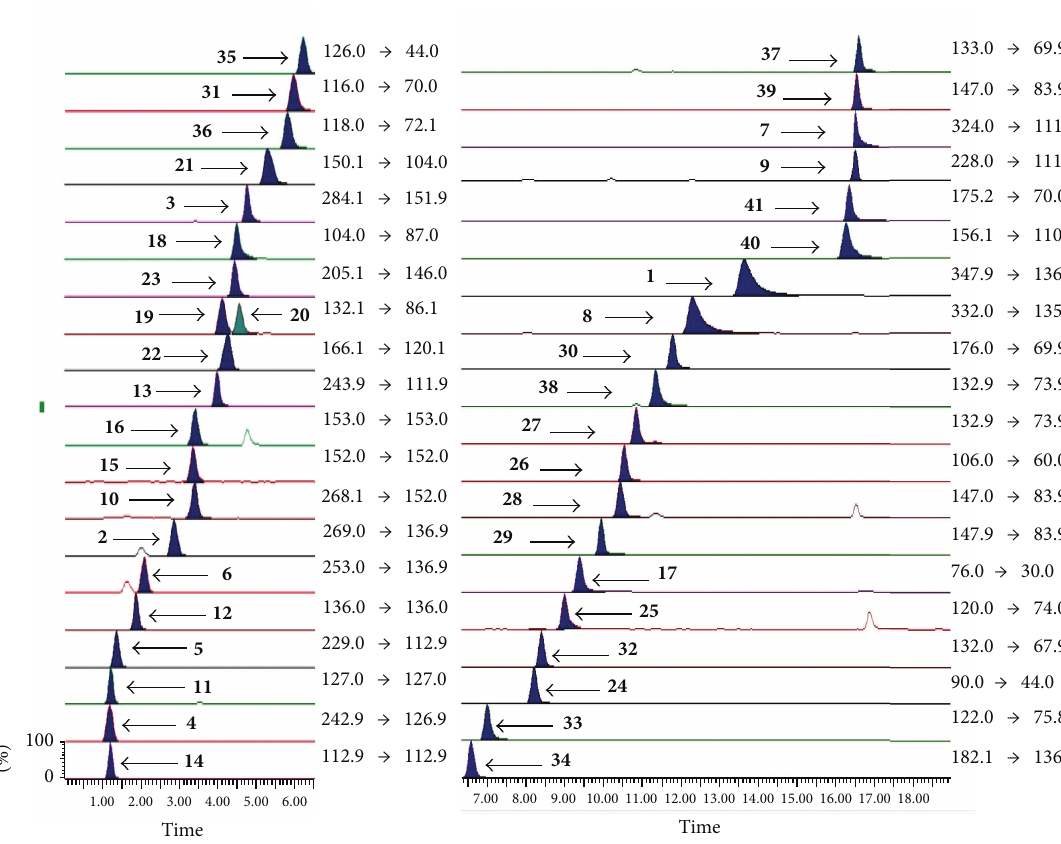
Figure 1: UPLC-TQ-MS/MS multiple-reaction monitoring (MRM) chromatograms of the samples. The compound numbers on the chromatograms were adenosine-5 󸀠 -monophosphate ( 1 ), inosine ( 2 ), guanosine ( 3 ), thymidine ( 4 ), 2 󸀠 -deoxyuridine ( 5 ), 2 󸀠 -deoxyinosine ( 6 ), cytidine-5 󸀠 -monophosphate ( 7 ), 2 󸀠 -deoxyadenosine-5 󸀠 -monophosphate ( 8 ), 2 󸀠 -deoxycytidine ( 9 ), 2 󸀠 -deoxyguanosine ( 10 ), thymine ( 11 ), adenine ( 12 ), cytidine ( 13 ), uracil ( 14 ), guanine ( 15 ), xanthine ( 16 ), glycine ( 17 ), GABA ( 18 ), leucine ( 19 ), isoleucine ( 20 ), methionine ( 21 ), phenylalanine ( 22 ), tryptophan ( 23 ), alanine ( 24 ), threonine ( 25 ), serine ( 26 ), asparagine ( 27 ), glutamine ( 28 ), glutamate ( 29 ), citrulline ( 30 ), proline ( 31 ), hydroxyproline ( 32 ), cysteine ( 33 ), tyrosine ( 34 ), taurine ( 35 ), valine ( 36 ), ornithine ( 37 ), aspartate ( 38 ), lysine ( 39 ), histidine ( 40 ), and arginine ( 41 ),